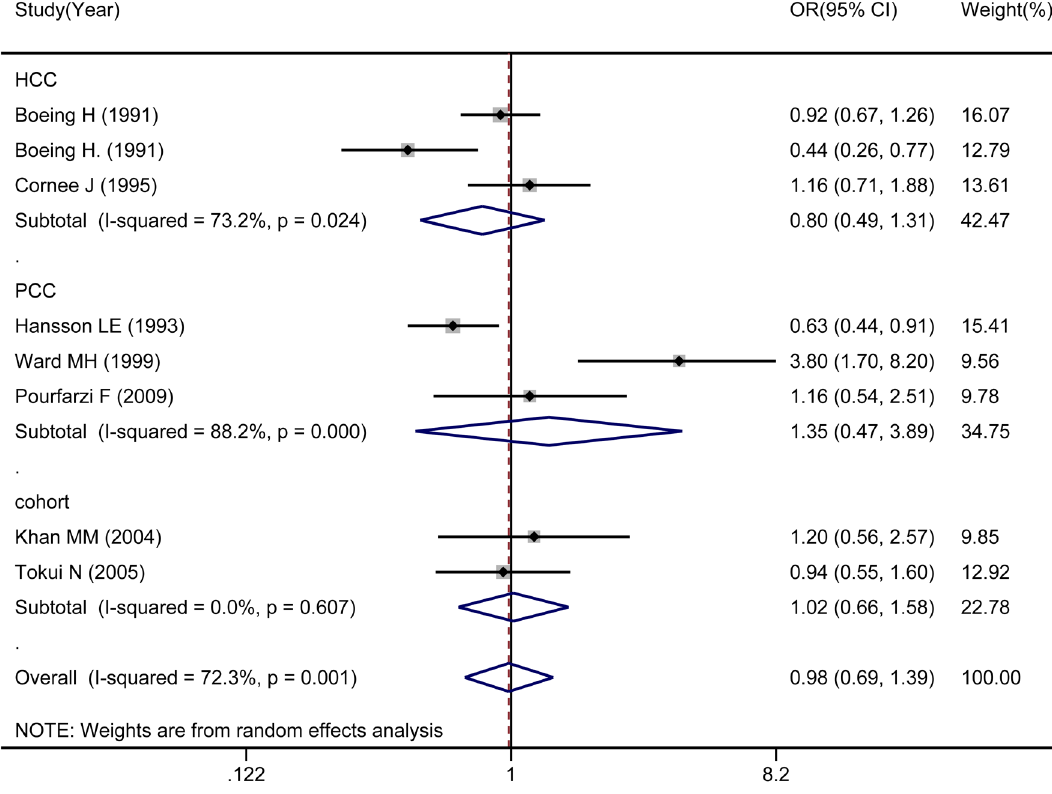
Figure 5. Consumption cheese in association with gastric cancer.